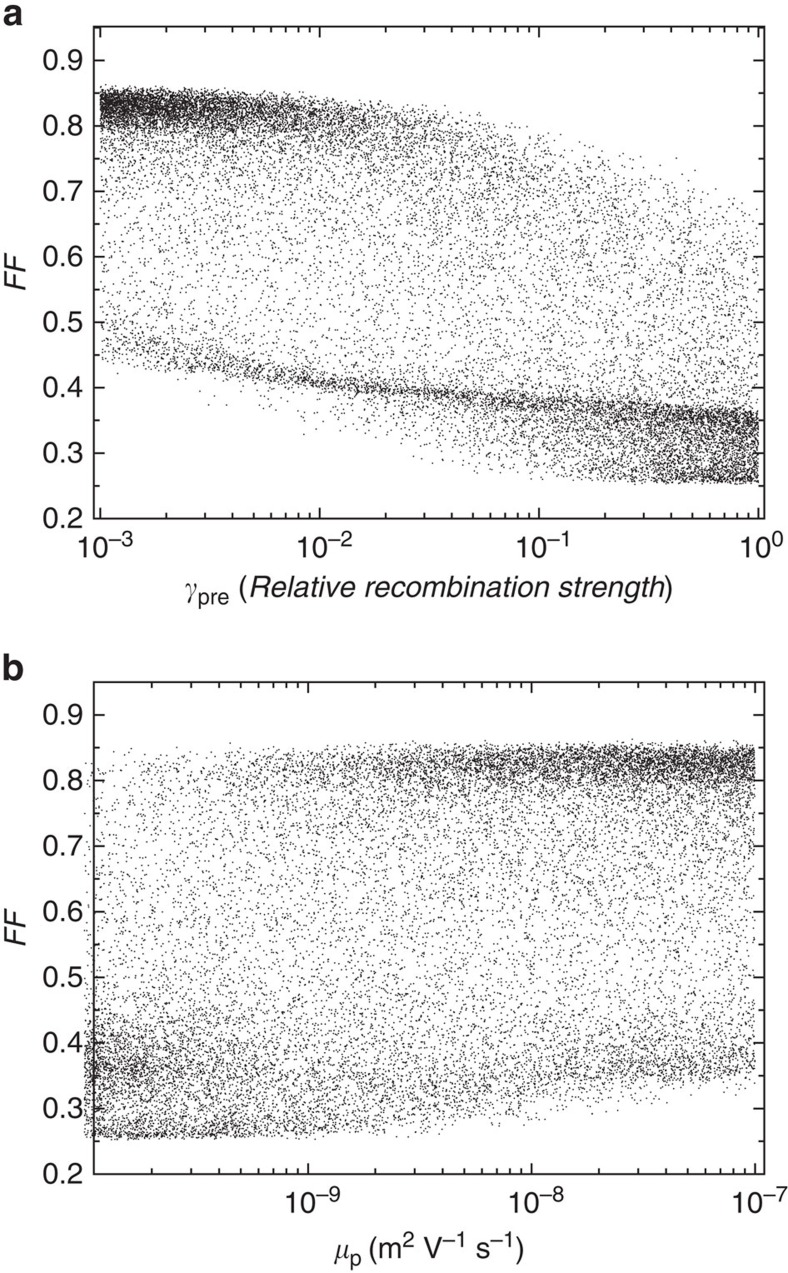
Dependency of the FF on the recombination prefactor and on the hole mobility.FF versus γpre (a) and μp (b) for the simulated data.